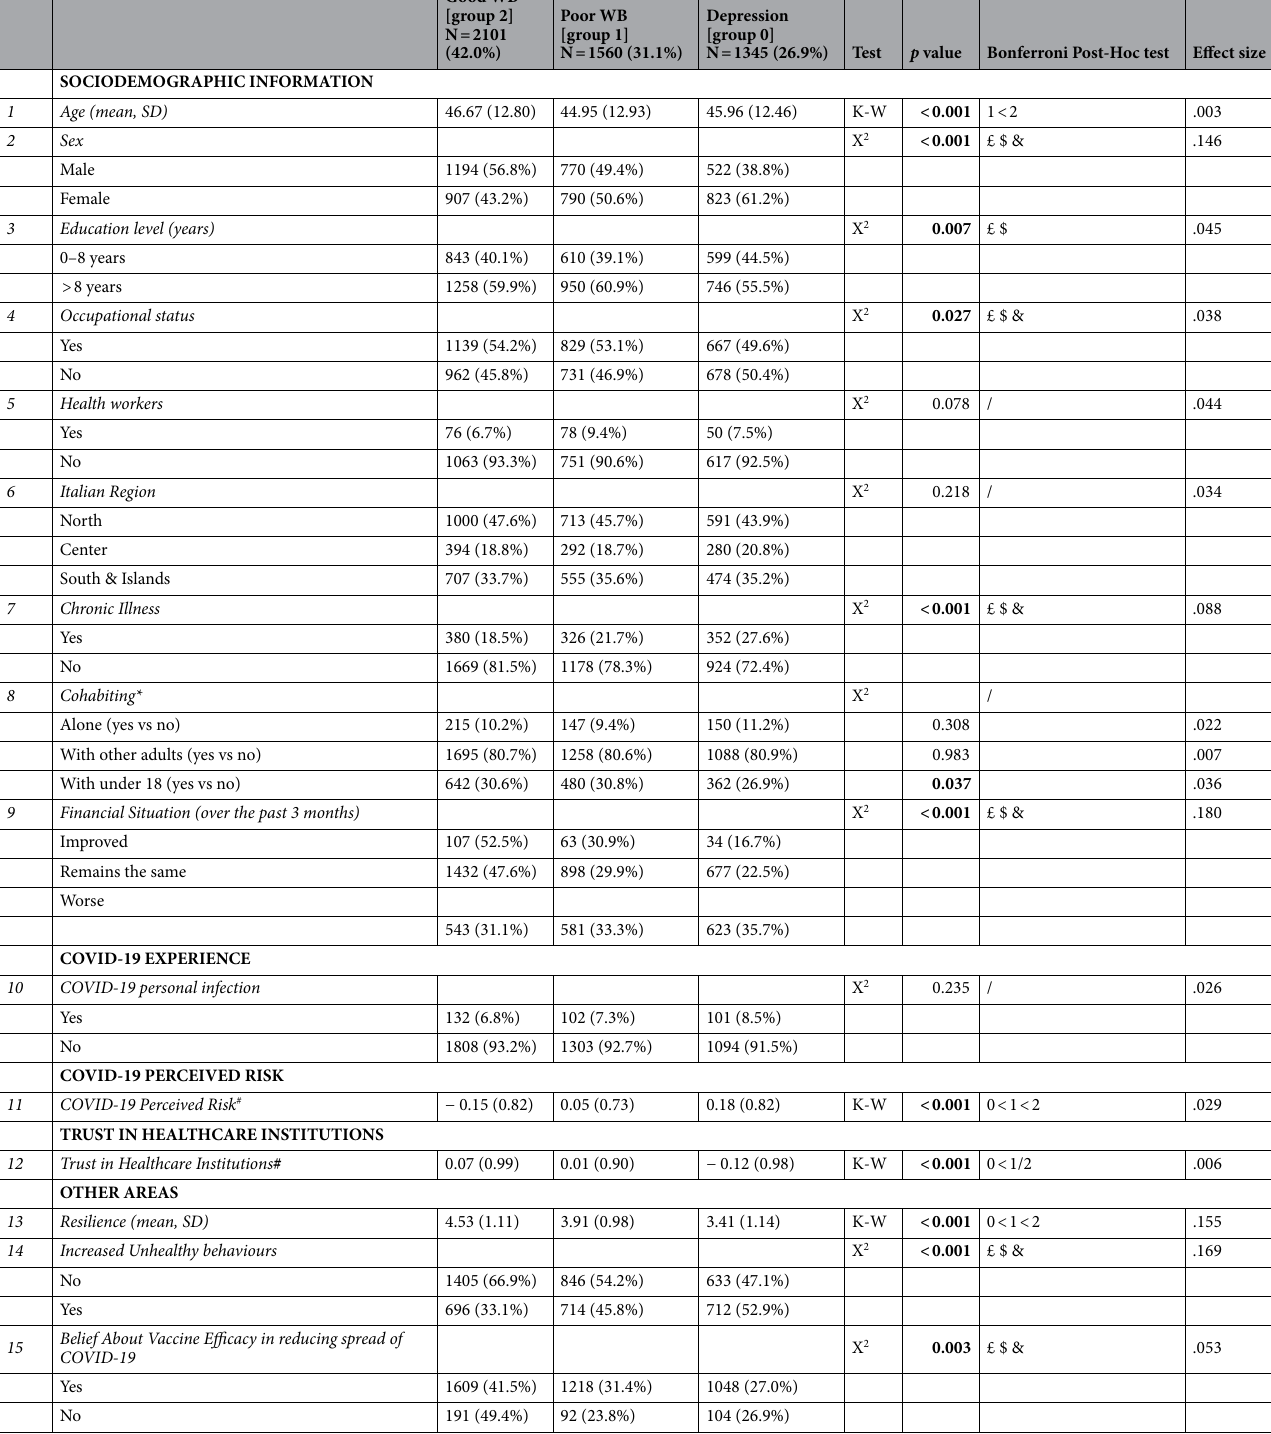
Table 1. Sample composition and selected characteristics according to WHO-5 scores (Wave 1–2). K-W: Kruskal–Wallis test; X 2 : Chi-square test. # Variables resulted by application of the Factor Analysis and obtained as the extraction of the first factor applied to single items of the WHO questionnaire. Factor analysis for COVID-19 Perceived risk included the following items: Probability, Vulnerability, Severity, Affect-Frightening and Affect-Closeness. Factor analysis for Trust in Healthcare institutions included the items: Family doctor, Hospitals, Ministry of Health, Institute of Public Health. £: Good WB versus Poor WB; $ Good WB versus Dep; &: Poor WB versus Dep. Significant values are in